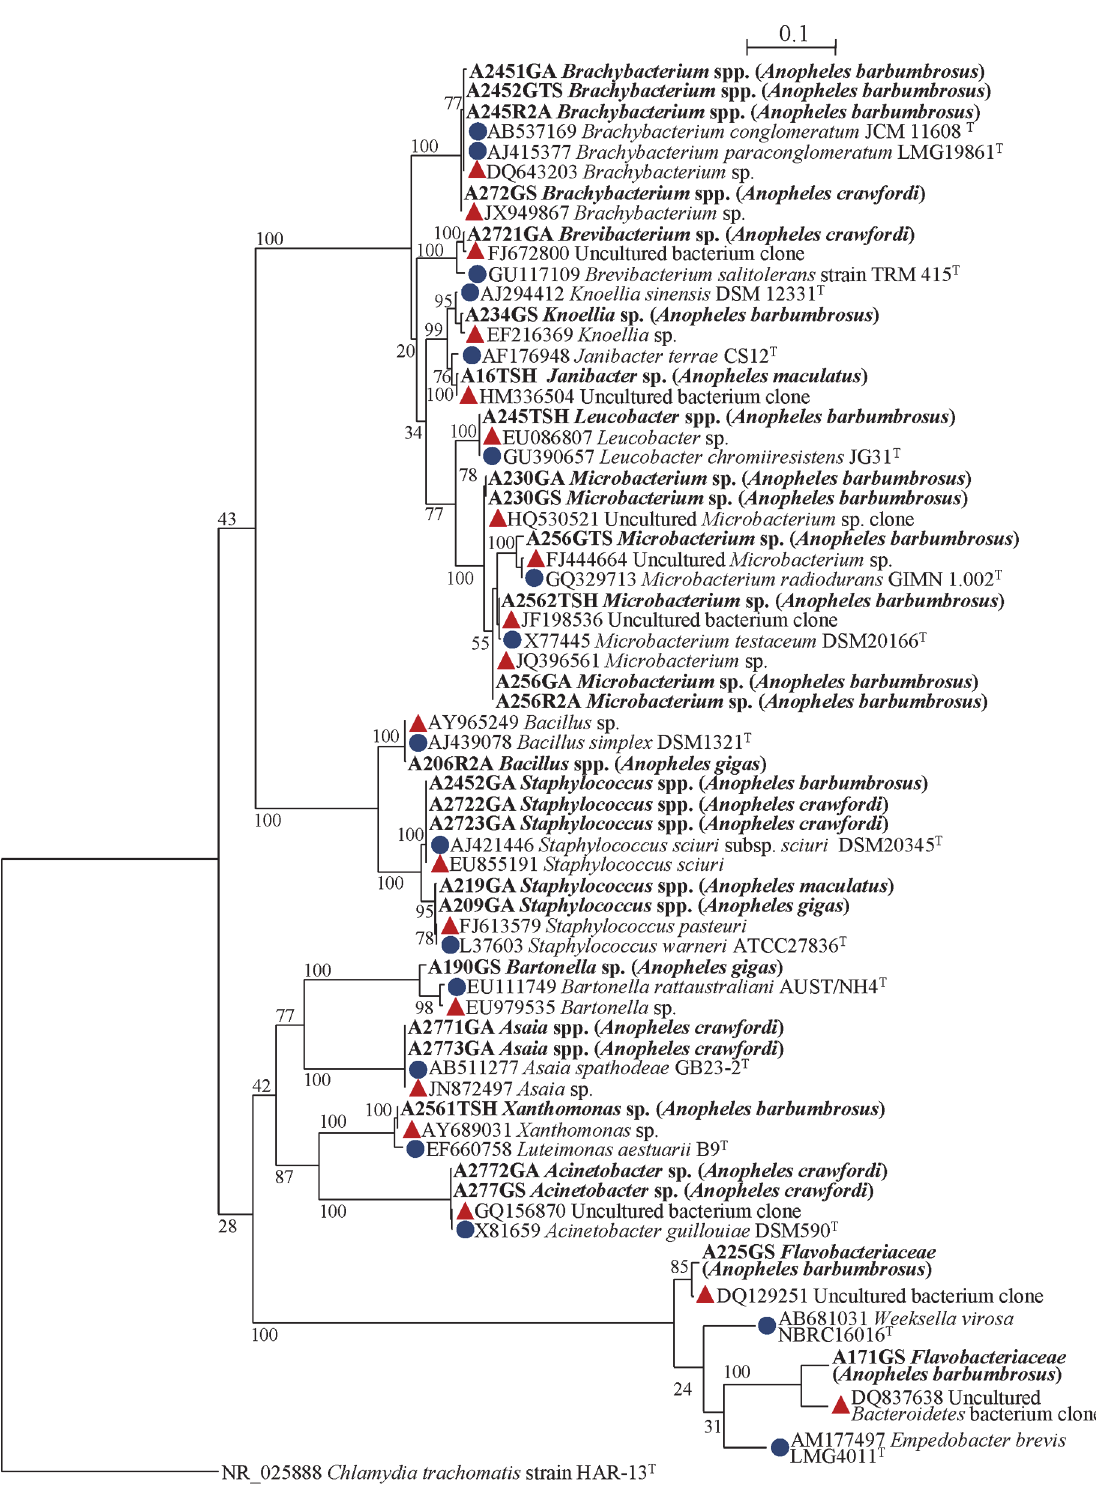
Fig 2. Maximum-likelihood phylogenetic tree showing the position of bacterial strains culture-isolated from abdomens of Anopheles species collected in Dak Nong, Vietnam. The horizontal lines show genetic distance. The numbers at the nodes are support values estimated with 100 bootstrap replicates. The scale bar indicates the number of substitutions per nucleotide position. Chlamydia trachomatis HAR-13 T was used as the outgroup bacteria. The sequences of isolates are shown in bold, the closest sequences (red triangle) and the sequences of the closest species type strain (blue circle) are shown with their GenBank accession number and their annotation. More information on the sequences used is detailed in Table 2.